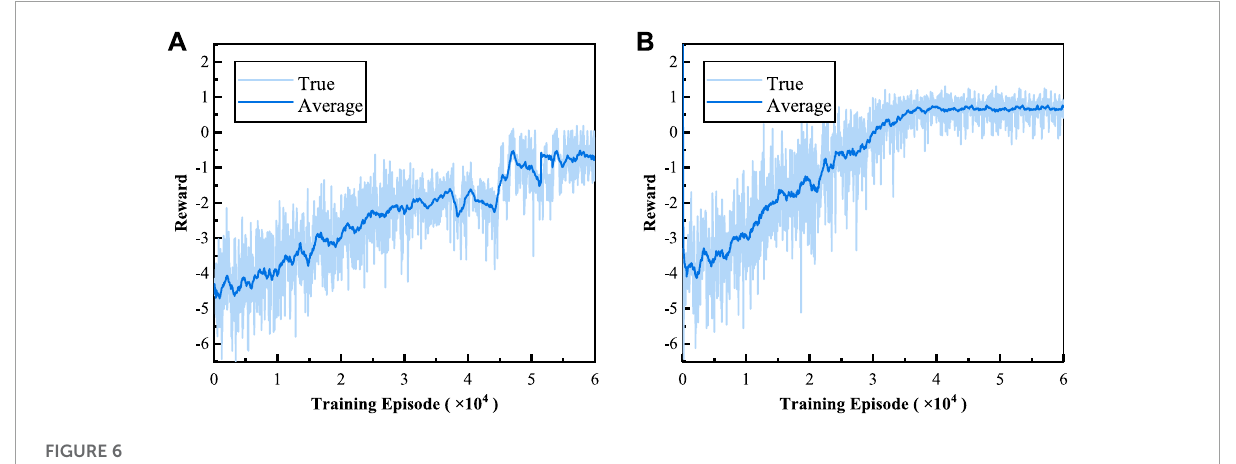
FIGURE 6 Reward curves in the training process: (A) DDPG and (B) TD3.